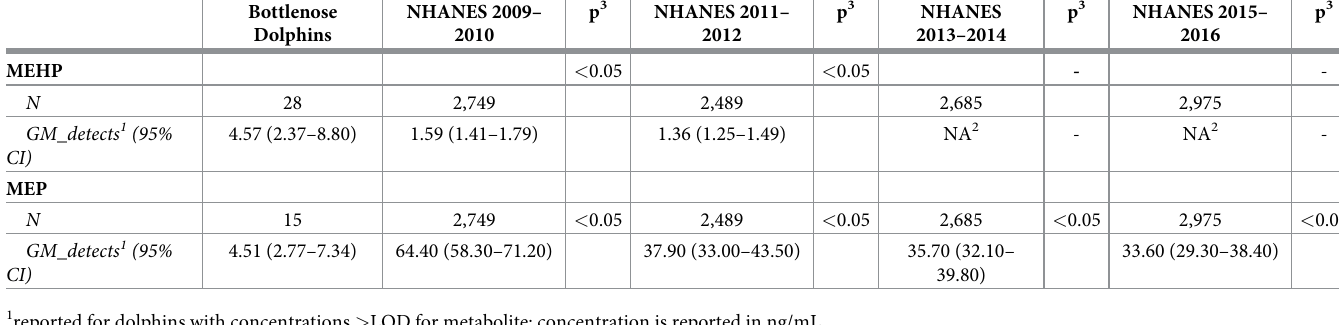
Table 4. Comparison of detectable concentrations of urinary phthalate metabolites between bottlenose dolphins sampled in Sarasota Bay, FL, USA (2010–2019) and human reference populations (NHANES; 2009–2010, 2011–2012, 2013–2014, 2015–2016). Bottlenose Dolphins